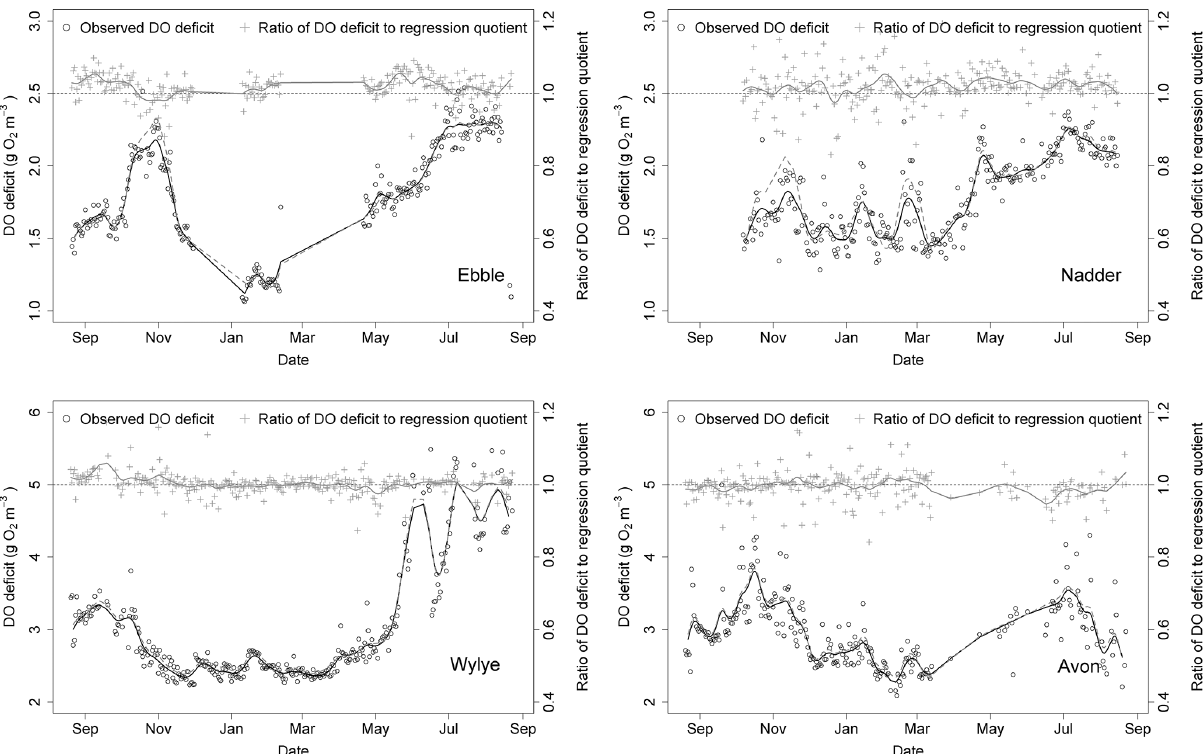
Figure 9. Time series (2014–2015) of the DO deficit at points of zero DO change (black circles) and comparison with corresponding ratio derived from nighttime regression (grey crosses). Trend lines are shown for both time series. For grey dashed line (Nadder), see